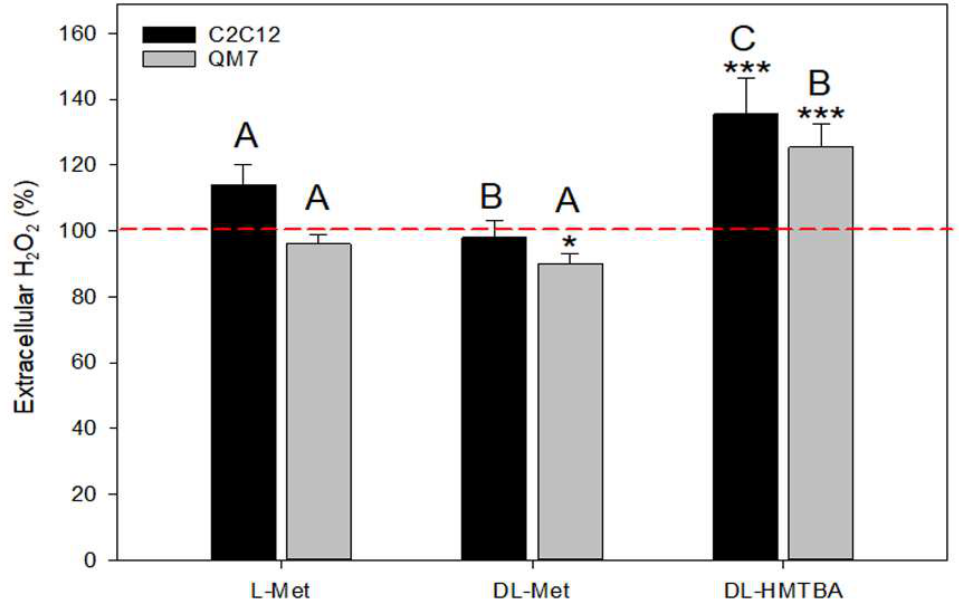
Figure 6. Extracellular H 2 O 2 concentration in medium for C2C12 and QM7 cells after supplementa- tion with 1000 µM of L-Met, DL-Met, or DL-HMTBA. Cells were seeded at a density of 25,000 cells per well. The concentration of extracellular H 2 O 2 was determined at 48, 72, and 96 h after supple- mentation, and data from all time points were pooled, as there was no significant time dependency detected. The H 2 O 2 concentration in the control medium was set to 100%, and the H 2 O 2 concentra- tion after supplementation is given as a percentage of the control. DL-Met significantly reduced extracellular H 2 O 2 levels in QM7 cells. DL-HMTBA enhanced H 2 O 2 secretion in both tested cell lines. * p ≤ 0.05 and *** p ≤ 0.001 vs. control; A, B, and C uppercase letters show significant differences between supplements within a concentration value ( p ≤ 0.05); N = 30.